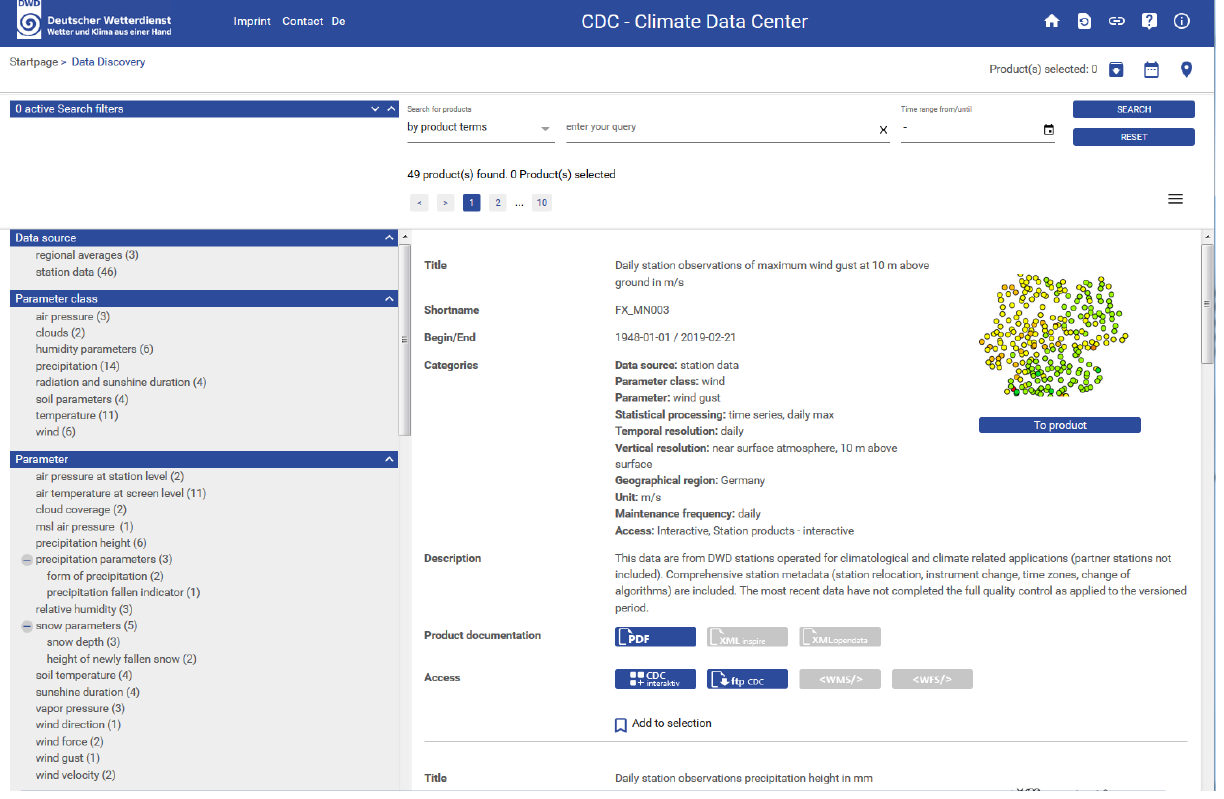
Figure 2. Screenshot of the search page. The left part shows the facet-based selection area that allows narrowing the search results. The right part shows the search results. In this example four data access methods are available: Interactive access, download from an FTP-server, WMS and WFS (Source: Deutscher